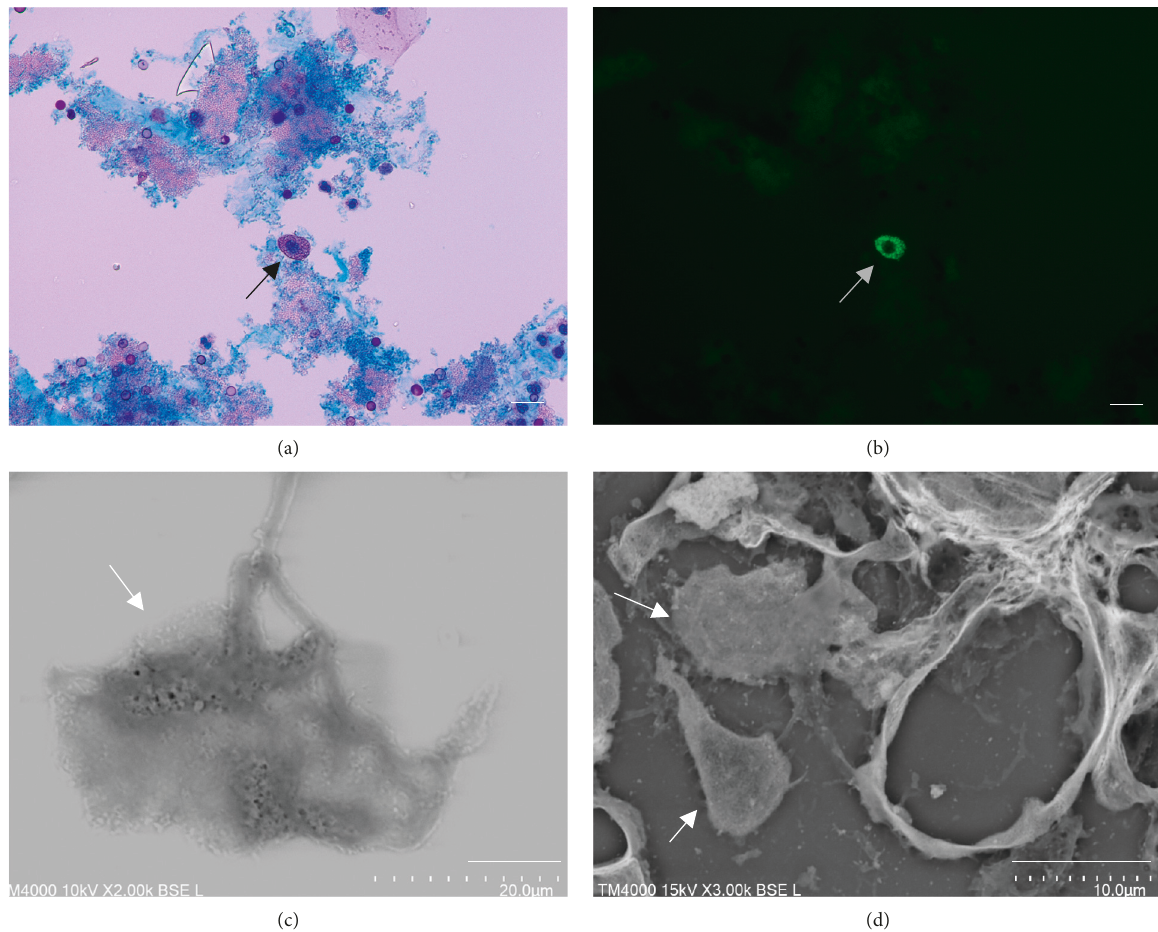
Figure 1: Light microscopy of urinary podocytes (a), immunofluorescence staining for podocalyxin (b), LVSEM observation (c), and PAM staining of the renal biopsy sample of the same patient (d). The arrows indicate podocytes. Bars indicate 10 µ m.